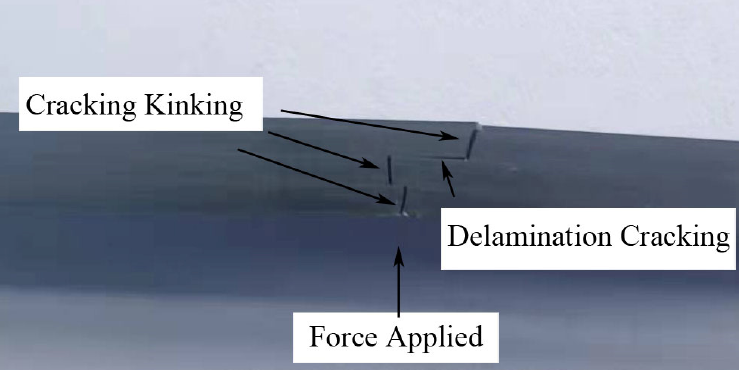
Figure 7. Optical image of the side-view of the gradual-layered sample after the three-point-bending test.